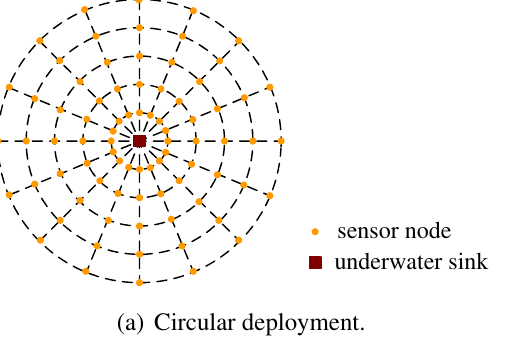
Figure 7. Two-dimensional underwater sensor network